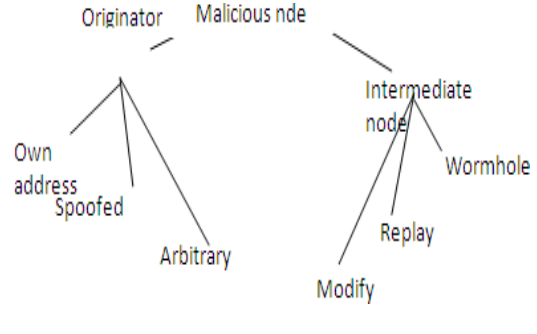
Figure 5: Representation of a malicious attack